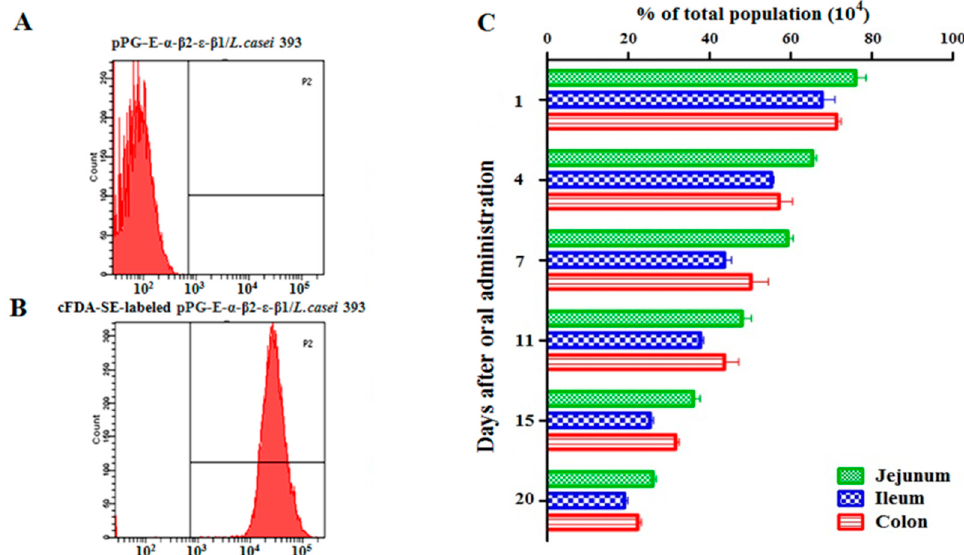
Figure 3. Colonization ability in the intestine of the recombinant lactobacillus. ( A , B ) Unlabeled and cFDA-SE-labeled pPG-E- α - β 2- ε - β 1 / L. casei analyzed using flow cytometry. ( C ) Colonization of the recombinant lactobacillus in the intestinal tracts of rabbits. Results showed that the colonization rate of the recombinant lactobacillus gradually decreased, while the positive rate of the cFDA-SE-labeled lactobacillus still maintained 20–25% on day 20 after oral